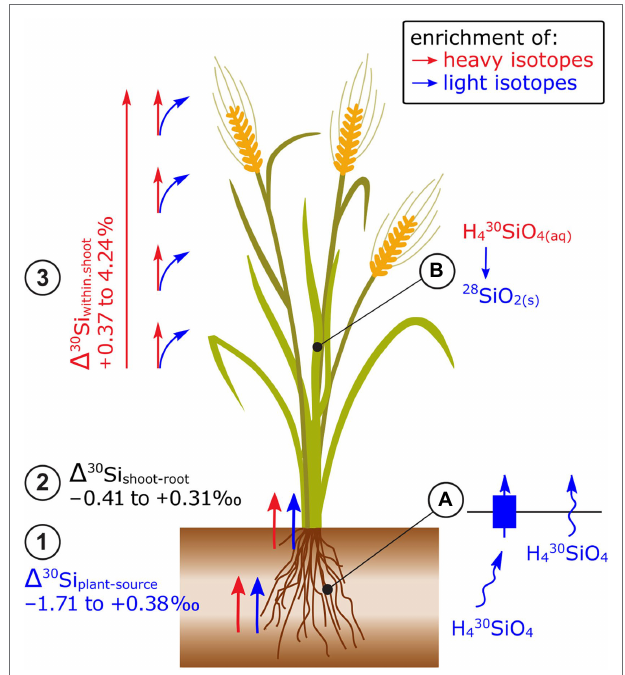
FIGURE 4 | Si isotope fractionation in plants exemplified for cereals. (1) Root uptake of Si leads in most cases to an enrichment of light isotopes while (2) no consistent pattern of Si isotope fractionation has been observed between root and shoot. (3) Within the shoot, plants become significantly enriched in heavy isotopes along the transpiration stream leading to a strong enrichment of heavy isotopes in husks and grains of rice. (A) The preferential uptake of light isotopes has been ascribed to a non-membrane protein-mediated transfer of Si (non-Si accumulators) and a membrane protein-mediated transfer of Si (LSi1) in Si-accumulating plants. Both processes may be driven by Si diffusion that favors light Si isotopes. (B) Precipitation of light Si isotopes into phytoliths (SiO 2 ) results in an enrichment of heavy isotopes in the Si pool (H 430 SiO 4 ) and thereby in an enrichment of heavy isotopes along the transpiration